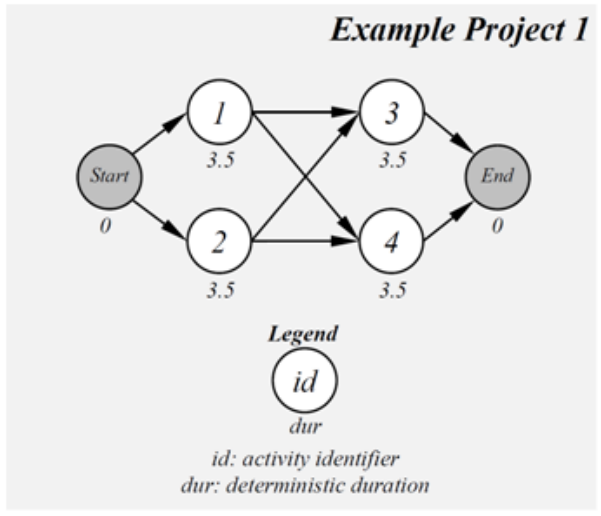
Figure 3. AoN network of the example project 1